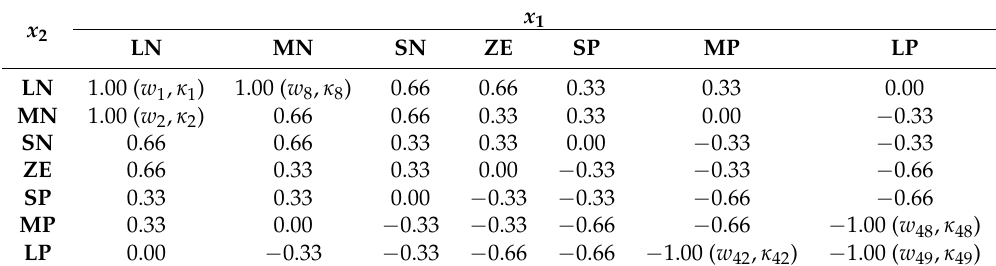
Table 1. Initial linking weights of HWANFC and the HWNF-based Gradient Estimator (HWNFGE).